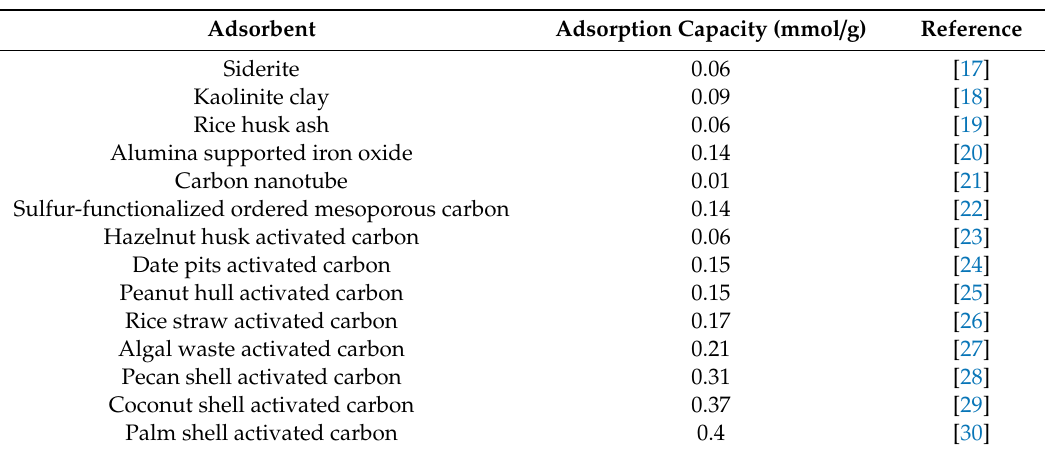
Table 2. Parameters and correlation regression for two models, Langmuir and Freundlich.